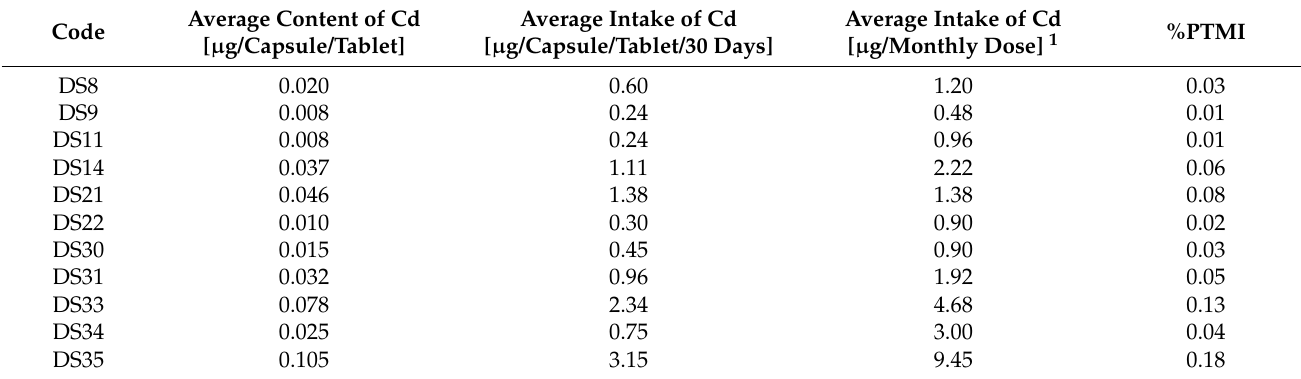
Table 7. Estimation of the tolerable monthly intake for Cd [%PTMI].